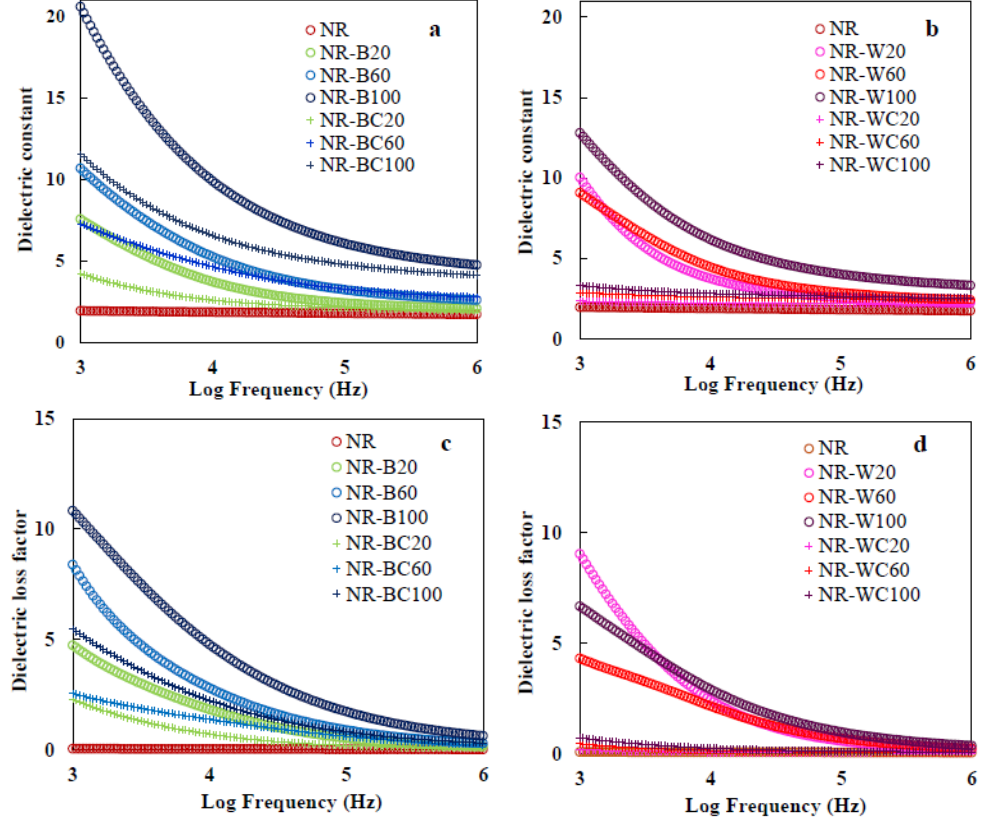
Figure 12. Dielectric constant of ( a ) NR, NR–B, NR–BC and ( b ) NR, NR–W, NR–WC and dielectric loss of ( c ) NR, NR–B, NR–BC and ( d ) NR, NR–W,